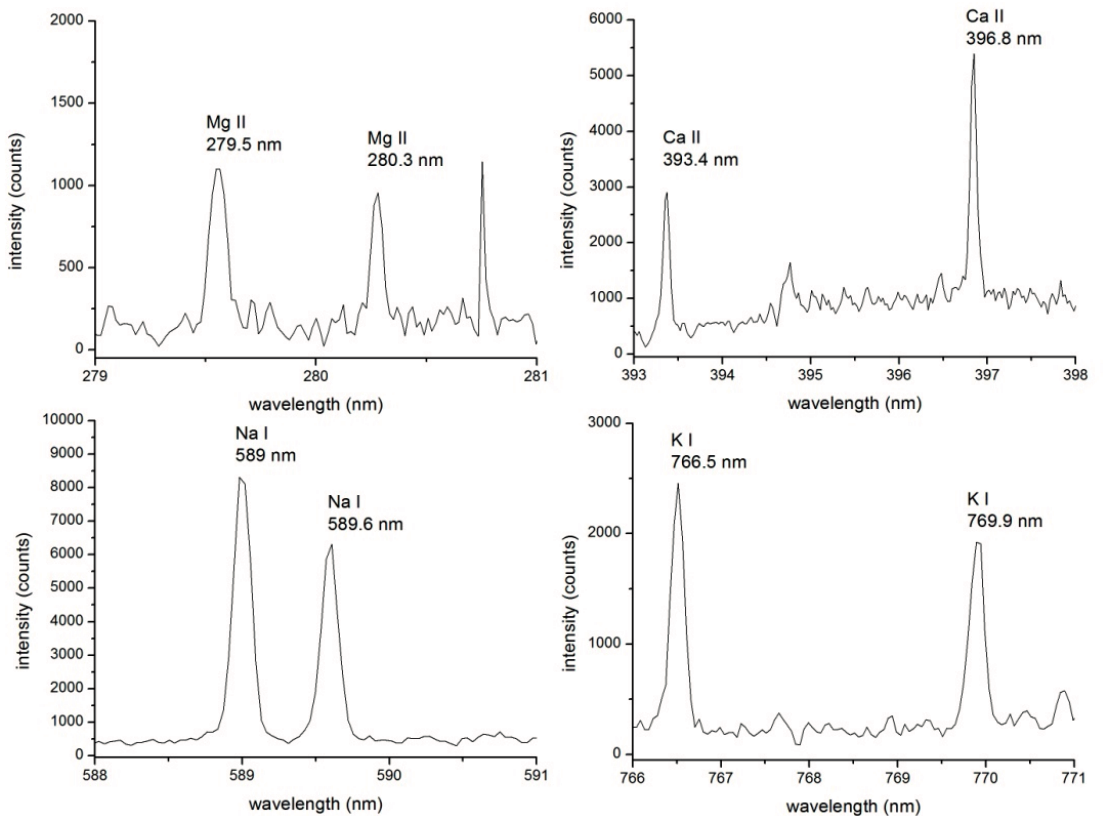
Figure 3. Typical spectrum of algae with the emphasis given to the matrix elements (Mg, Ca, Na, and